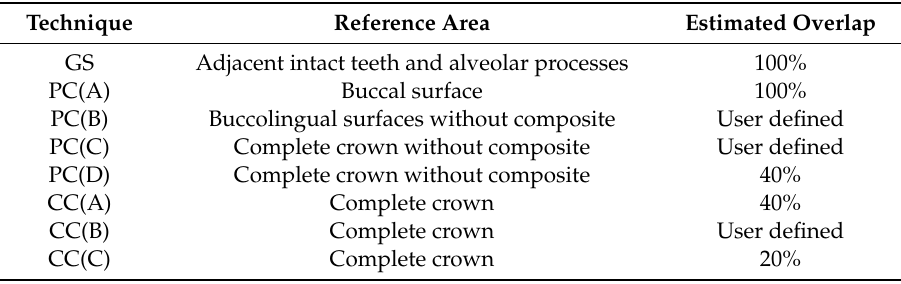
Table 1. Superimposition techniques tested in the study.